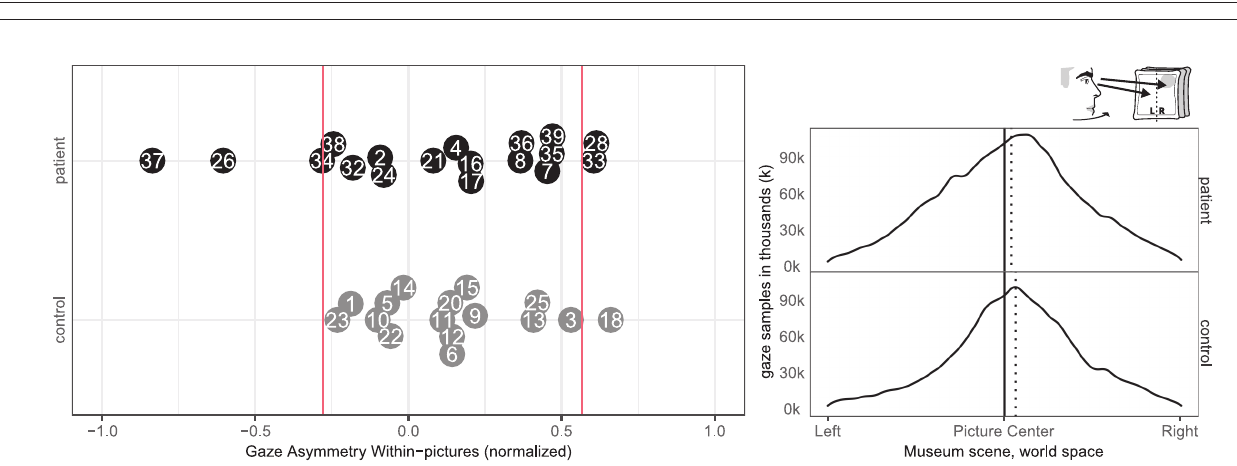
FIGURE 5 | Gaze Asymmetry Within-picture. (Left) Individual time spent looking right and left within all pictures in patient (black, top) and control (gray, bottom) with the empirical cut-offs (red lines). (Right) Spatial distribution of gaze samples within all pictures with true (solid) midline and group median (dotted).